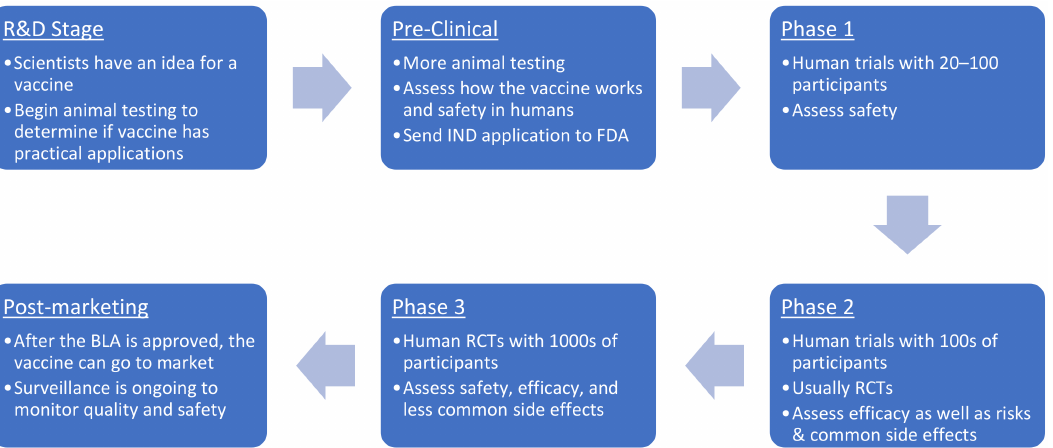
Figure 1. The FDA’s standard vaccine approval process. Abbreviations: R&D = Research & Develop- ment; IND = Investigational New Drug; FDA = Food and Drug Administration; RCT = Randomized